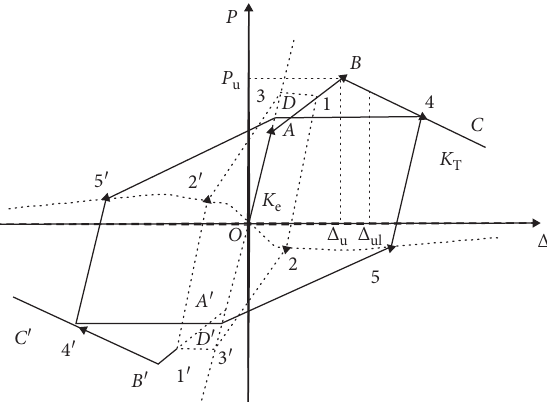
Figure 13: Simplified force-displacement